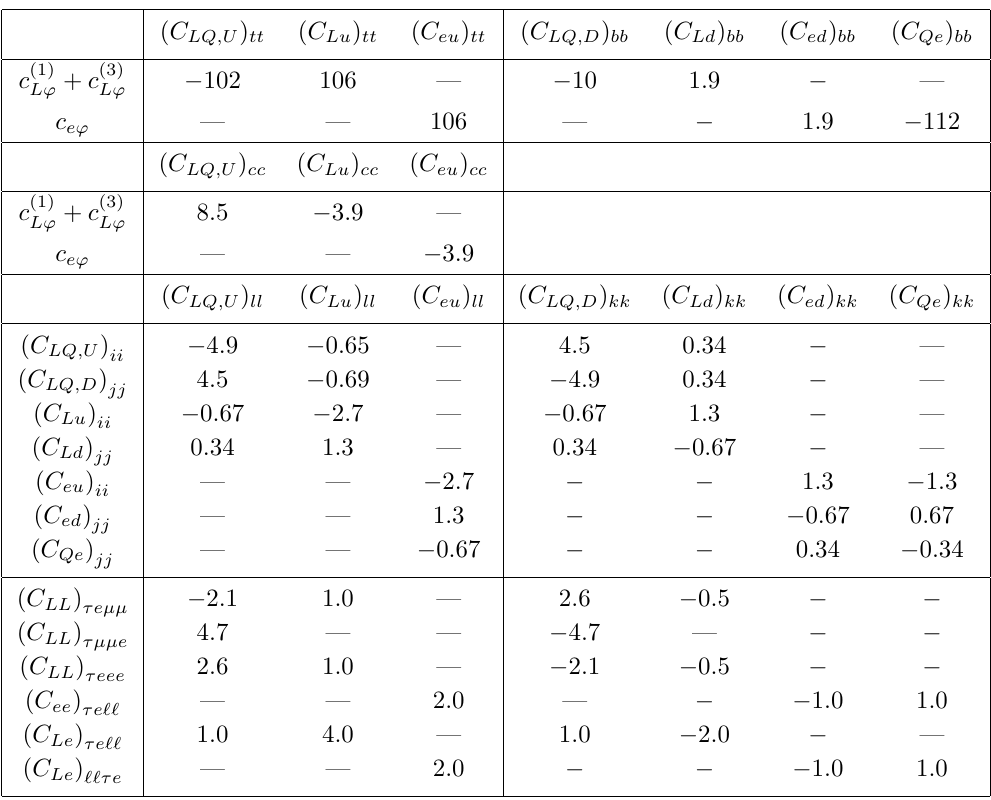
Table 21 . The Wilson coefficients at µ = m t induced by nonzero top-, bottom- and charm-quark operators at the scale Λ = 1 TeV, in units of 10 − 3 . The indices i , l and j , k denote, respectively, u - and d -type flavor indices, and we consider mixing onto operators of different flavor, i 6 = l , j 6 = k